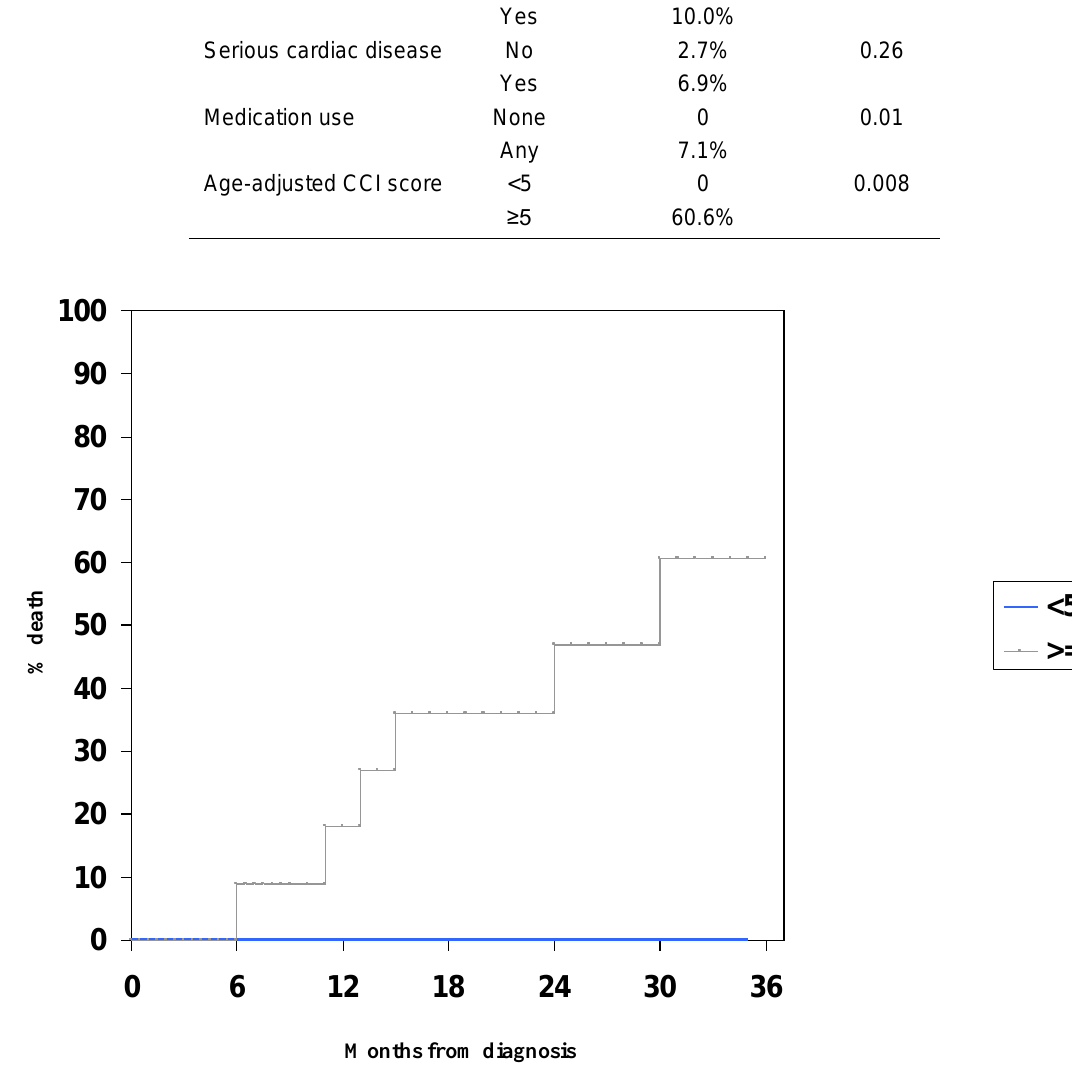
FIGURE 2. Actuarial risk of early non–prostate-cancer-related death in patients with age-adjusted CCI score <5 (n = 166) vs. ≥5 (n = 11); Kaplan-Meier analysis, log-rank test, p =